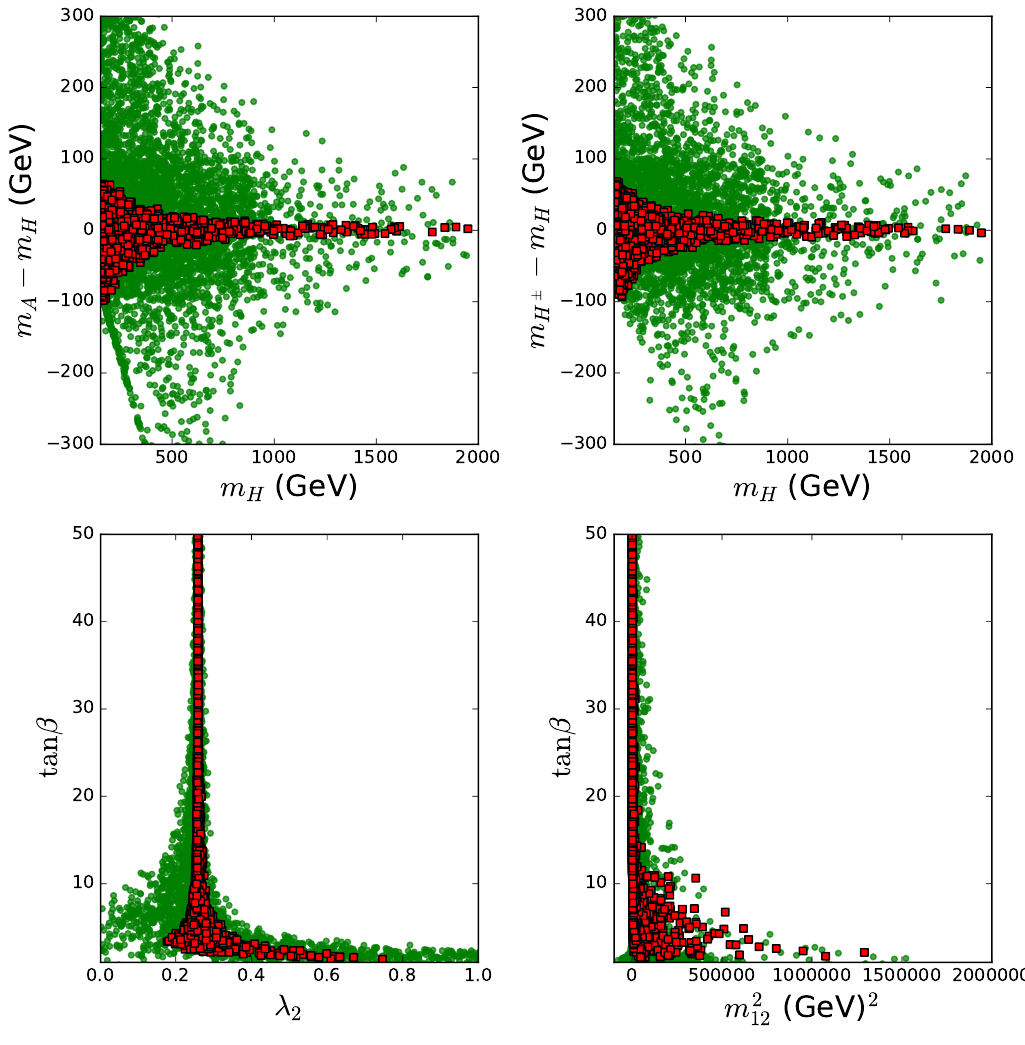
Figure 2 . For the type-I model, the bullets (green) satisfying the oblique parameters, the signal data of the 125 GeV Higgs, and theoretical constraints at the electroweak scale. The squares (red) satisfying the constraints of pre-inflation and h 2